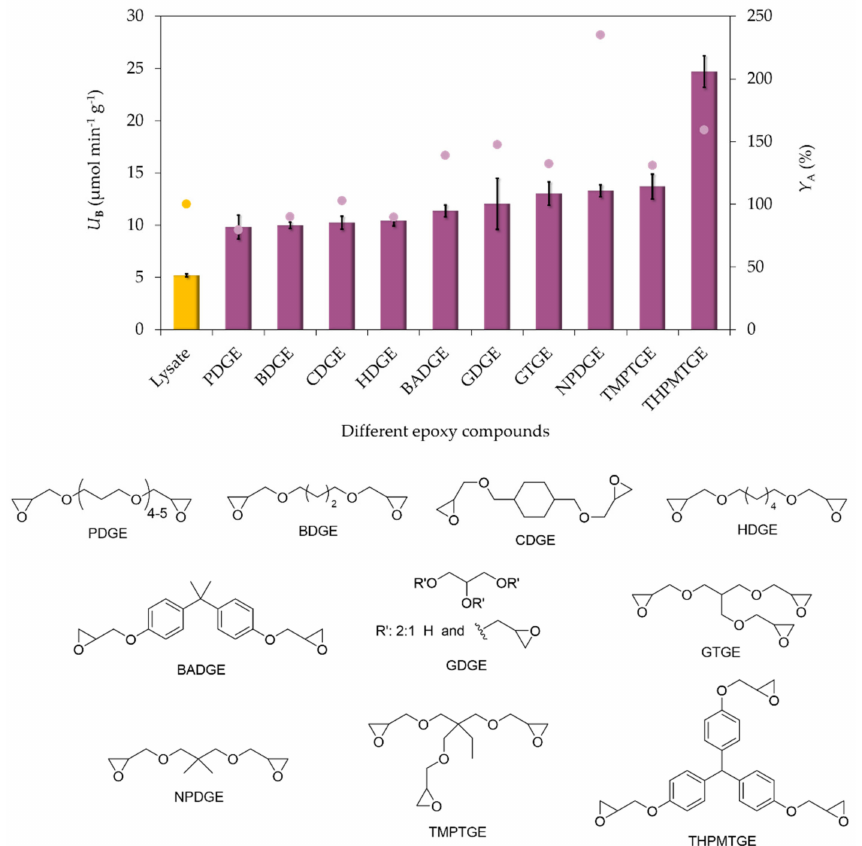
Figure 4. E ff ect of the nature of multiepoxide linkers on the activity and immobilization e ffi ciency of Pc PAL biocatalysts. Bars: specific biocatalytic activity ( U B ), dots: activity yield ( Y A ); for the non-immobilized cell-lysate U B = U E . The measurements were performed in three replicates; the standard deviation of activity yield values was always below 5%. Experiments were performed as described in Section